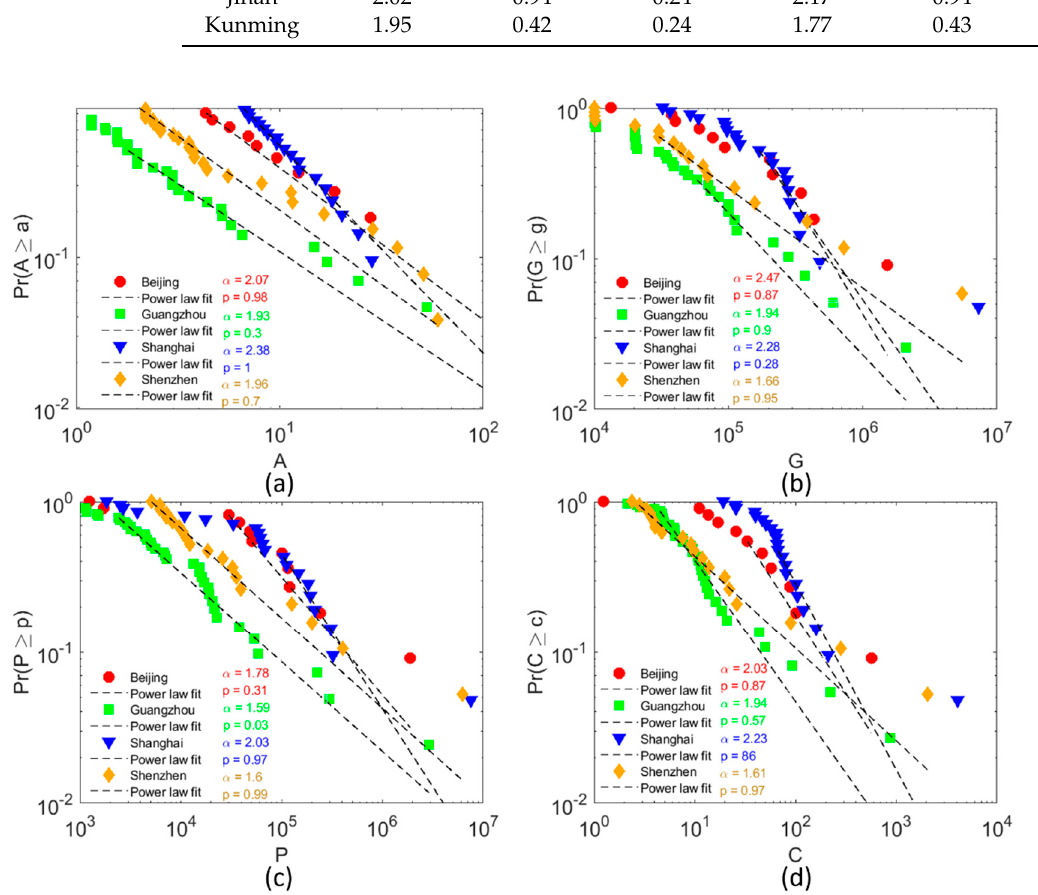
Figure 6. (Color online) Power law distribution of NTL-based hotspot sizes ( a ), GDP ( b ), population ( c ), and CO 2 emissions ( d ) among the top four cities in